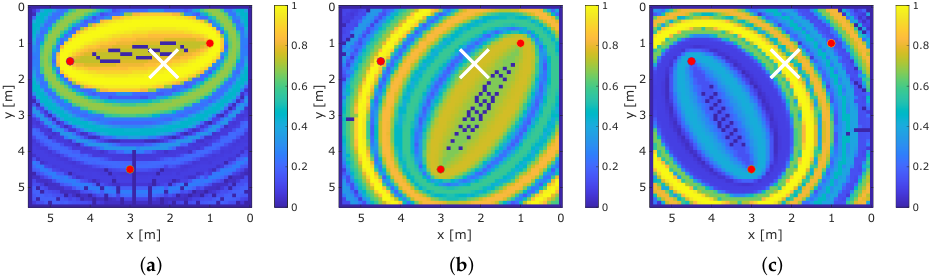
Figure 13. Single heat maps of sensor pairs of MSR that result in ambiguities. ( a ) MSR at position 6 pair (1,2). ( b ) MSR at position 6 pair (1,3). ( c ) MSR at position 6 pair (2,3).